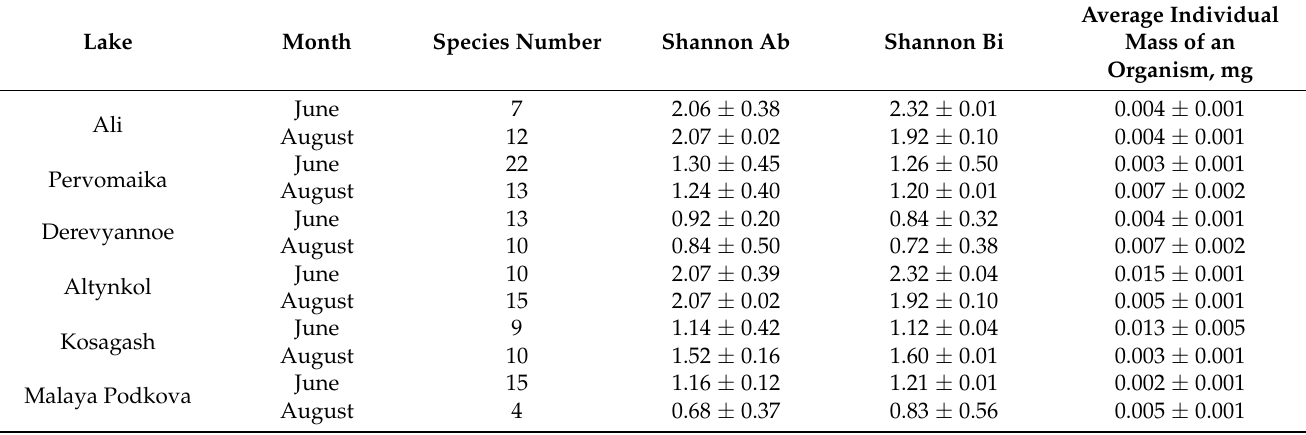
The lowest Shannon diversity of zooplankton found in Bolshaya Podkova in August. The highest zooplankton diversity recorded in Ali and Altynkol lakes. It did not change significantly throughout the season (Table 10). In August zooplankton diversity in the lakes Malaya Podkova, and Middle Kolsay was lower than in June. Table 10. Structural variables of zooplankton in small lakes in South-East Kazakhstan, mean values with standard deviation, summer